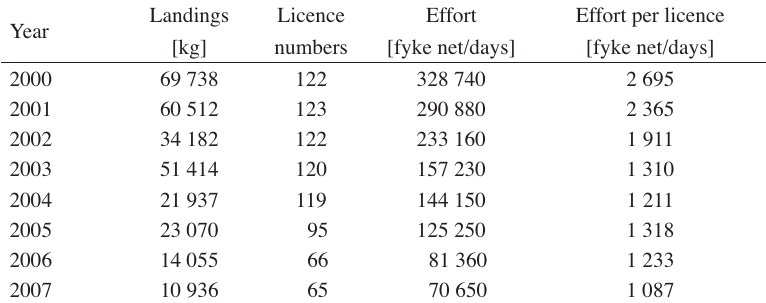
Landings and fyke net effort deployed at the Polish part of the Vistula Lagoon in 2000–2007 period